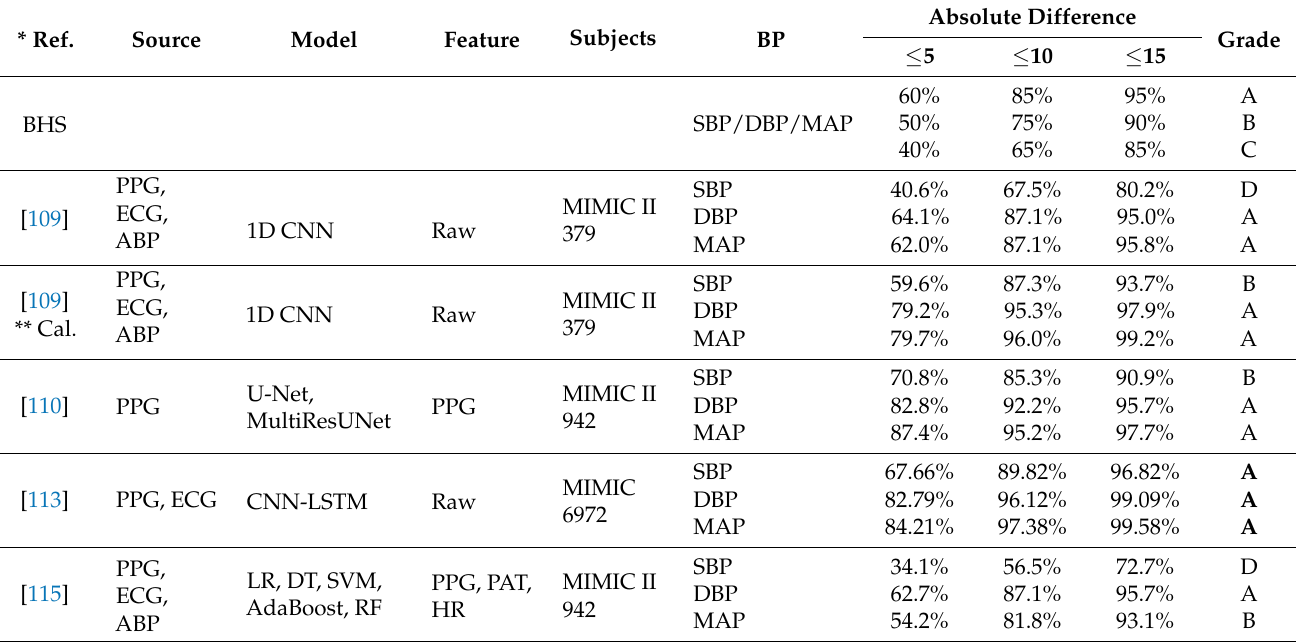
Table 2. Validation of algorithms based on BHS